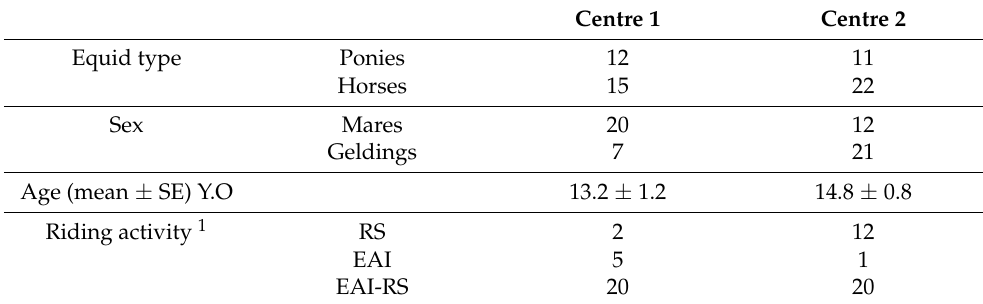
Table 1. Subject characteristics and management practices in the two study riding centers.